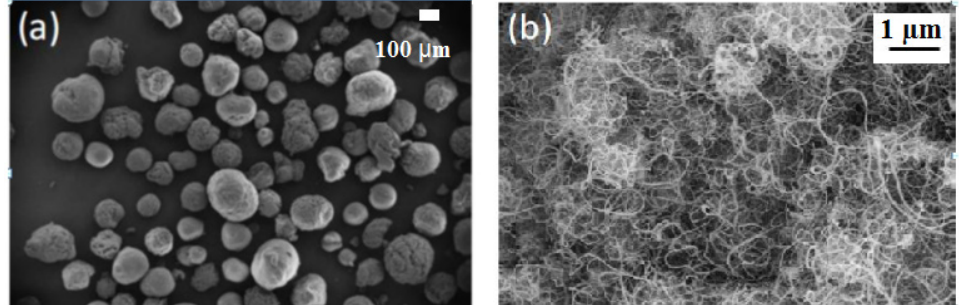
Figure 1. Structure of the bundled CNT ( a ); a zoom-in photo of the aggregates ( b ).